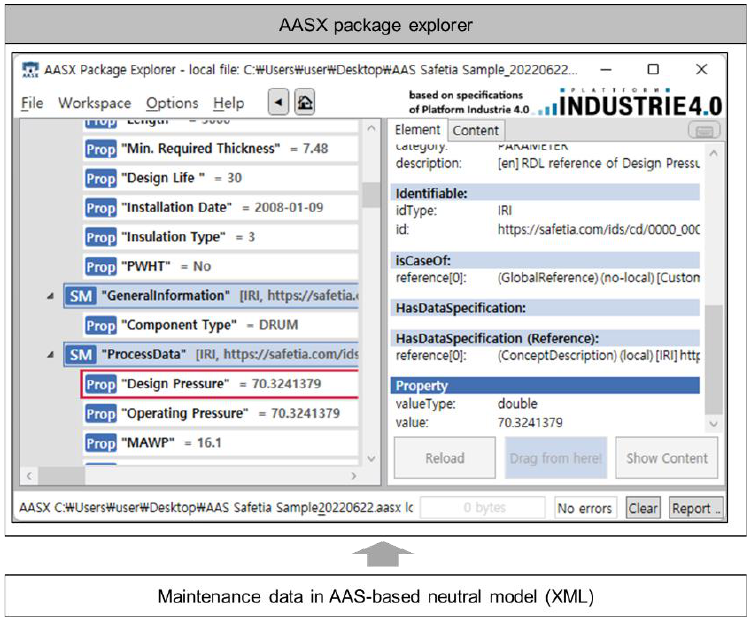
Figure 14. AAS conformance validation of converted neutral maintenance data.